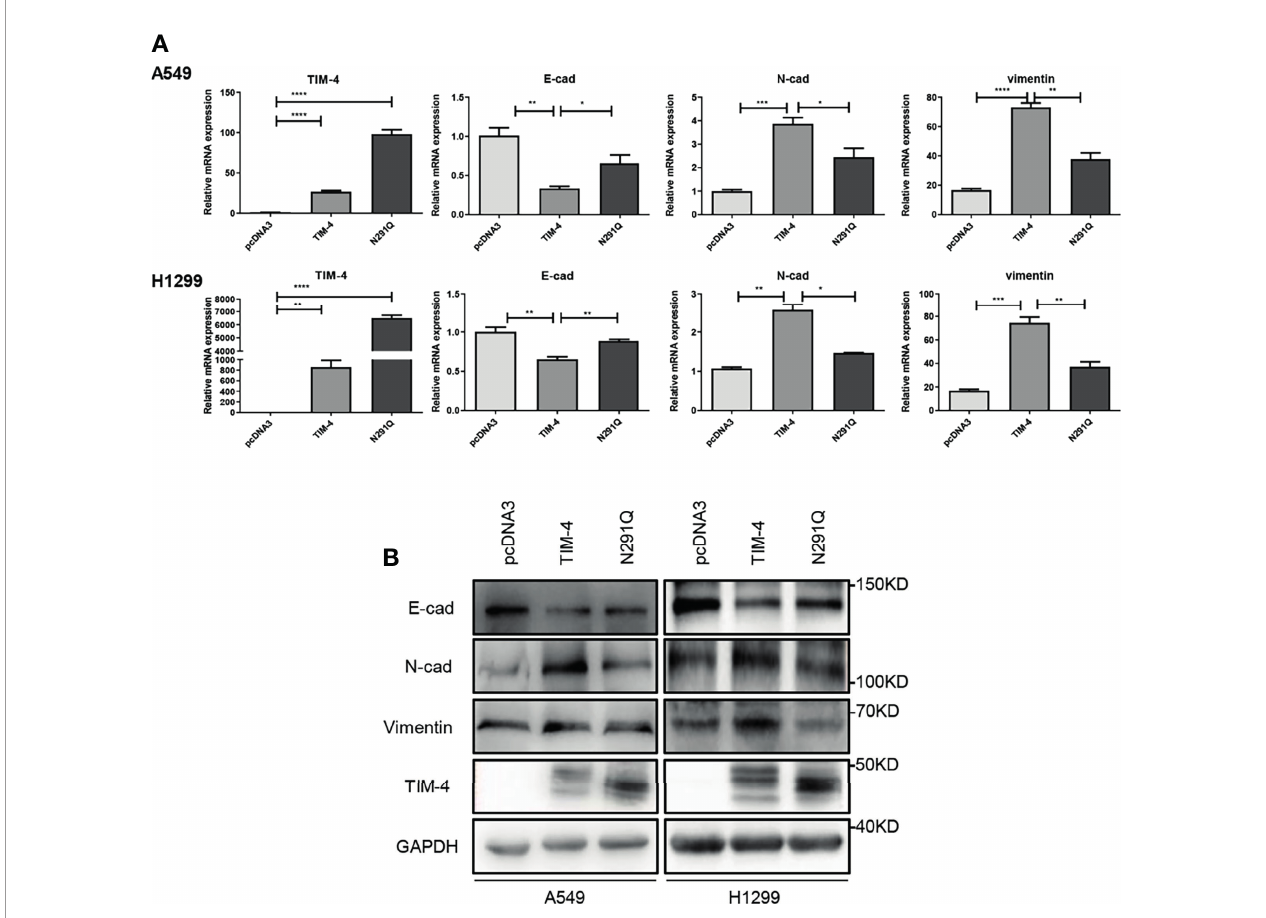
FIGURE 2 | N-glycosylated TIM-4 promotes EMT of NSCLC cells. (A) qPCR was used to detect the expression of TIM-4 and EMT related molecules in TIM-4-transfected and N291Q-transfected NSCLC cells. (B) Western Blot was used to detect the expression of TIM-4 and EMT related protein in TIM-4-transfected and N291Q-transfected NSCLC cells. All error bars were shown as mean ± SD of three independent experiments. *p < 0.05, **p < 0.01, ***p < 0.001, ****p < 0.0001, by Student ’ s